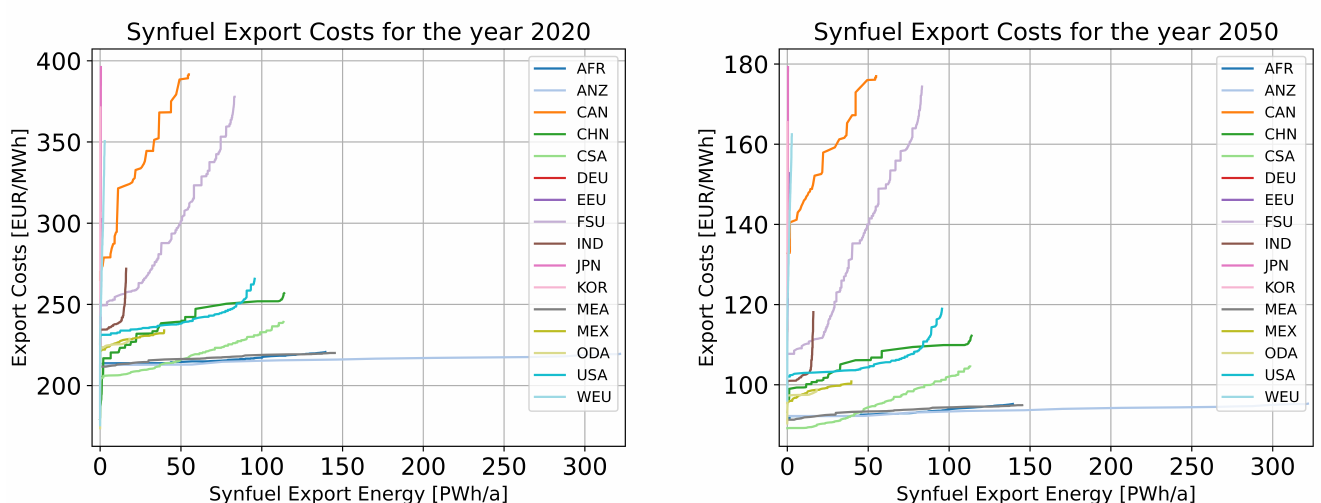
Figure 5. Supply curves for synthetic fuels in 2020 and